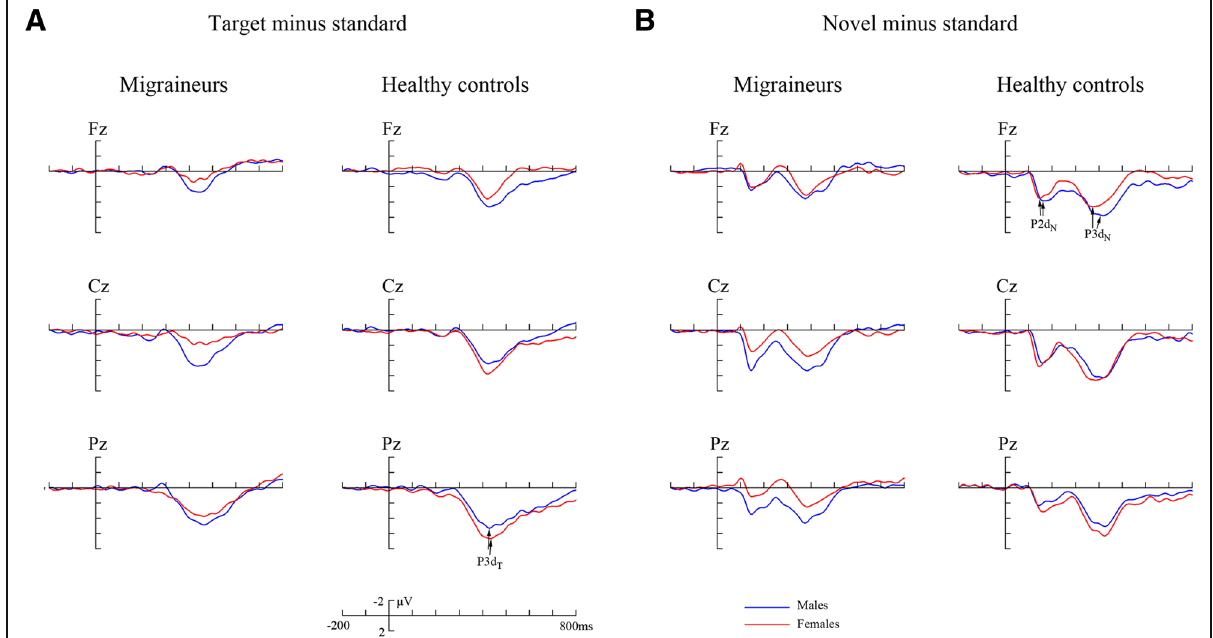
Fig. 3 The averaged difference waveforms in migraineurs and healthy controls at Fz, Cz and Pz, respectively. a Target minus standard difference ERPs; ( b ) novel minus standard difference ERPs. P3d T , P3d N and P2d N represent the P3 target effect, P3 and P2 novel effects, respectively. Blue line represents males and red line females